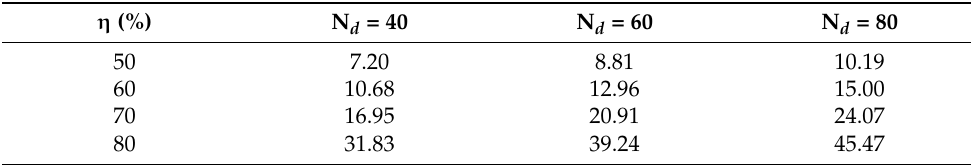
Figure 5. α is the angle between projected light and torus axis, and η is the ratio of height difference of the wire rope projection to the wire rope radius. N d is the ratio of the diameter of the drum to the diameter of the wire rope, usually designed as 40~80. Table 3. The values of µ for commonly used N d and η